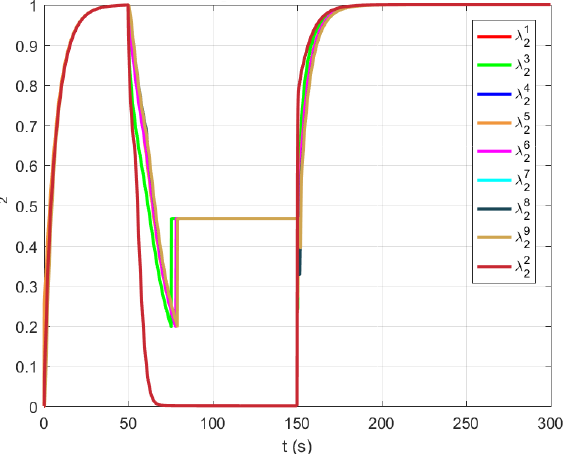
Figure 8. Time responses of the link a 12 weight on all agents in the system. At t = 50 s agent 2 fails and recovers at t = 150 s.